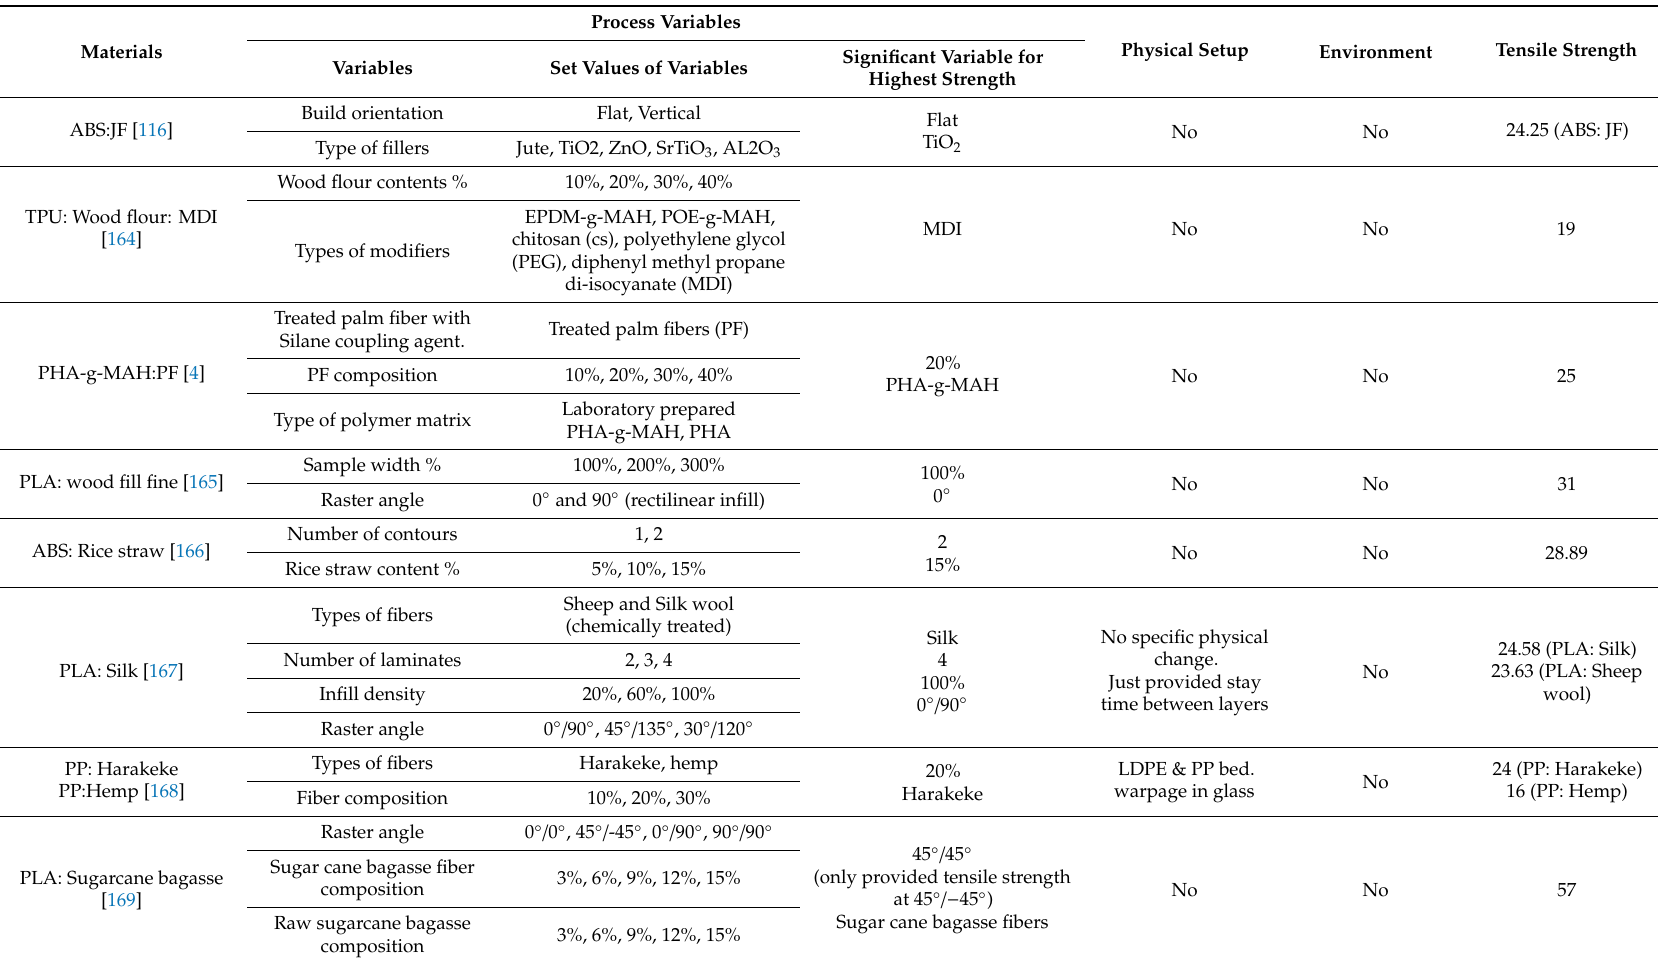
Table 5. Process factors for achieving high tensile strength for discontinuous natural fiber reinforced